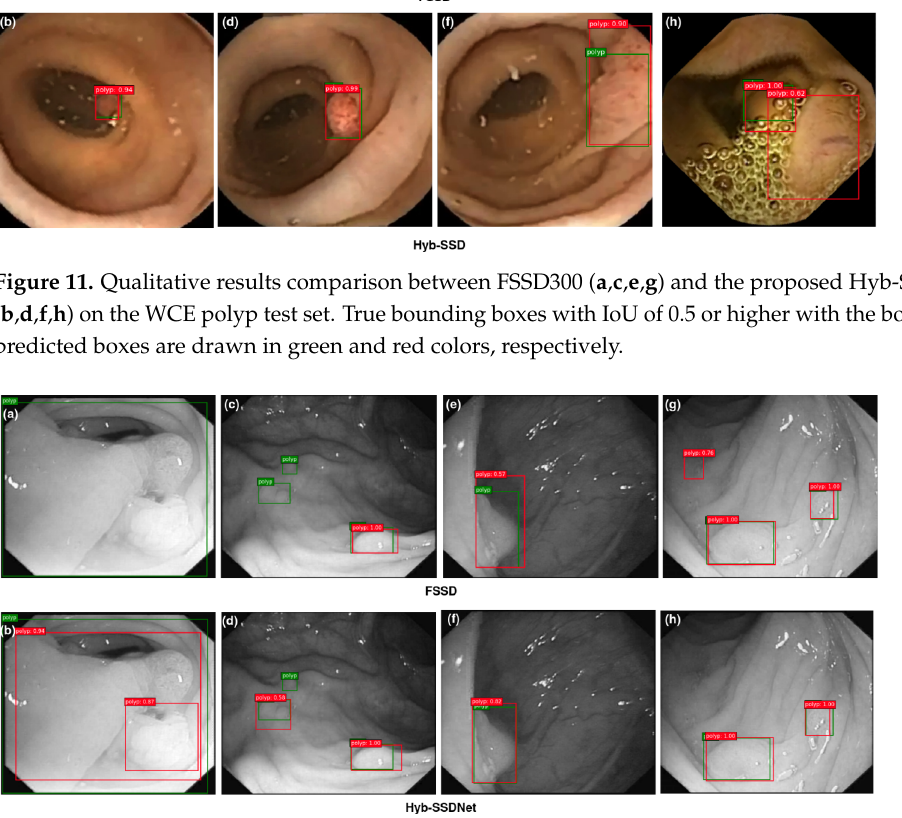
Figure 12. Qualitative results comparison between FSSD300 ( a , c , e , g ) and the proposed Hyb-SSDNet ( b , d , f , h ) on the CVC-ClinicDB polyp test set. True bounding boxes with IoU of 0.5 or higher with the bounding predicted boxes are drawn in green and red colors, respectively.